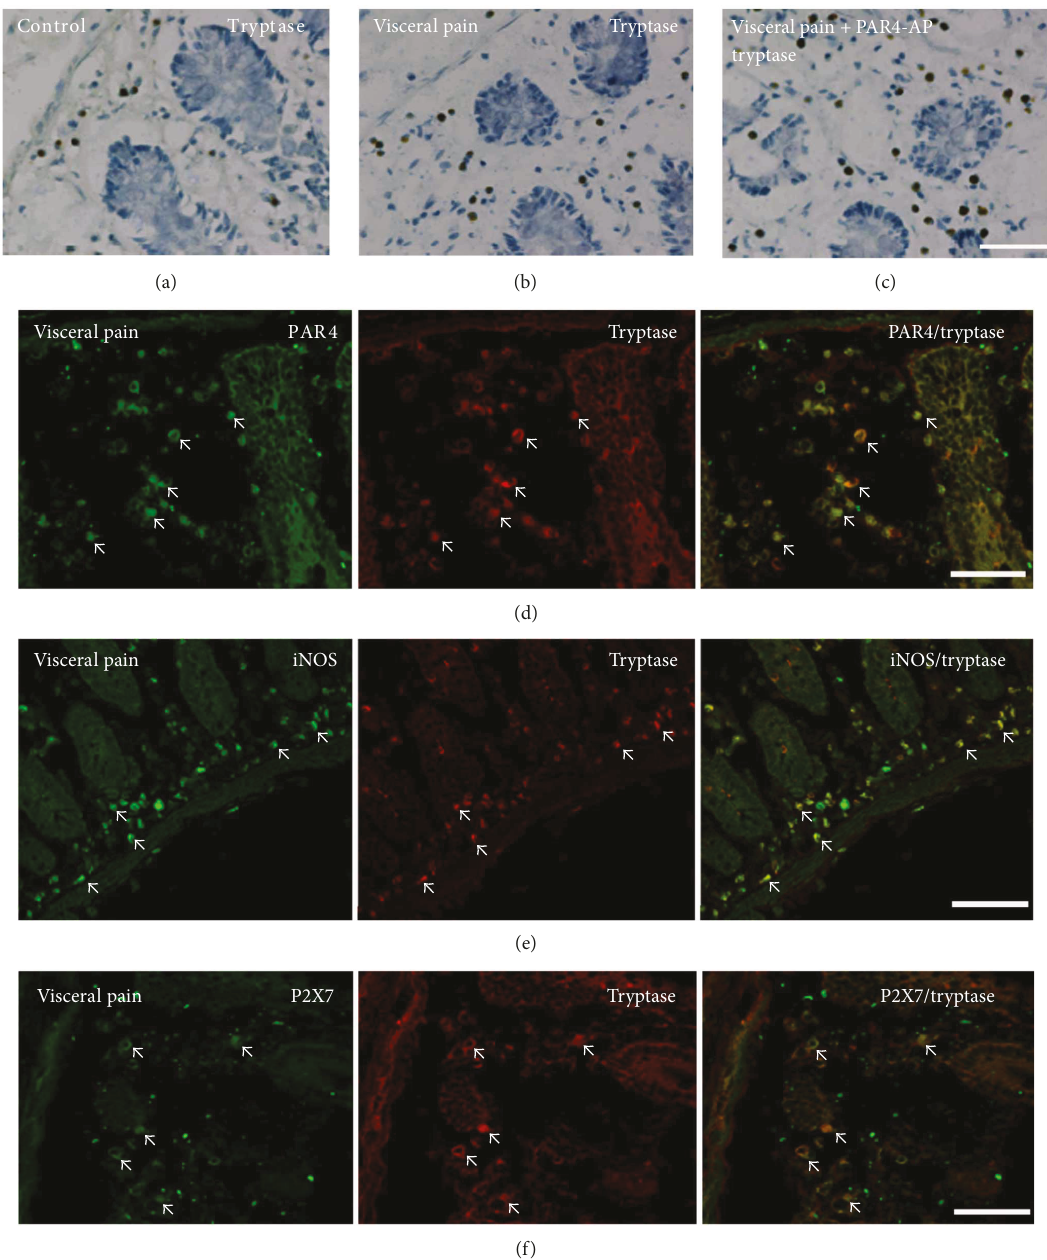
Figure 2: Expression of tryptase (AA1) and its colocalization with PAR4, iNOS, and P2X7 in the colonic mucosae of the visceral hyperalgesia rats. (a – c) Representative immunostainings for tryptase- (AA1-) positive MCs in the colonic sections are shown. The colonic sections were counterstained with toluidine blue. (d – f) Colonic sections from the visceral hyperalgesia rats costained with tryptase (AA1) and PAR4, iNOS, or P2X7 antibodies showing that the majority of the tryptase-positive MCs expressed PAR4, iNOS, or P2X7 (bar 100 μ